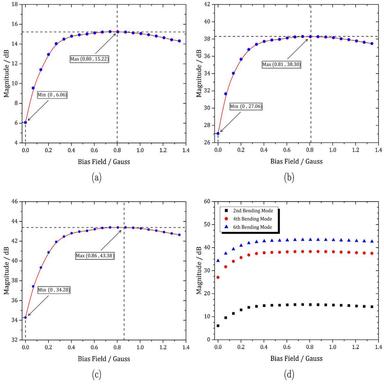
Metglas ribbons SNR graphs for the (a) 2nd, (b) 4th and (c) 6th bending modes of the cantilever beam. (d) SNR comparison plot for all bending modes.